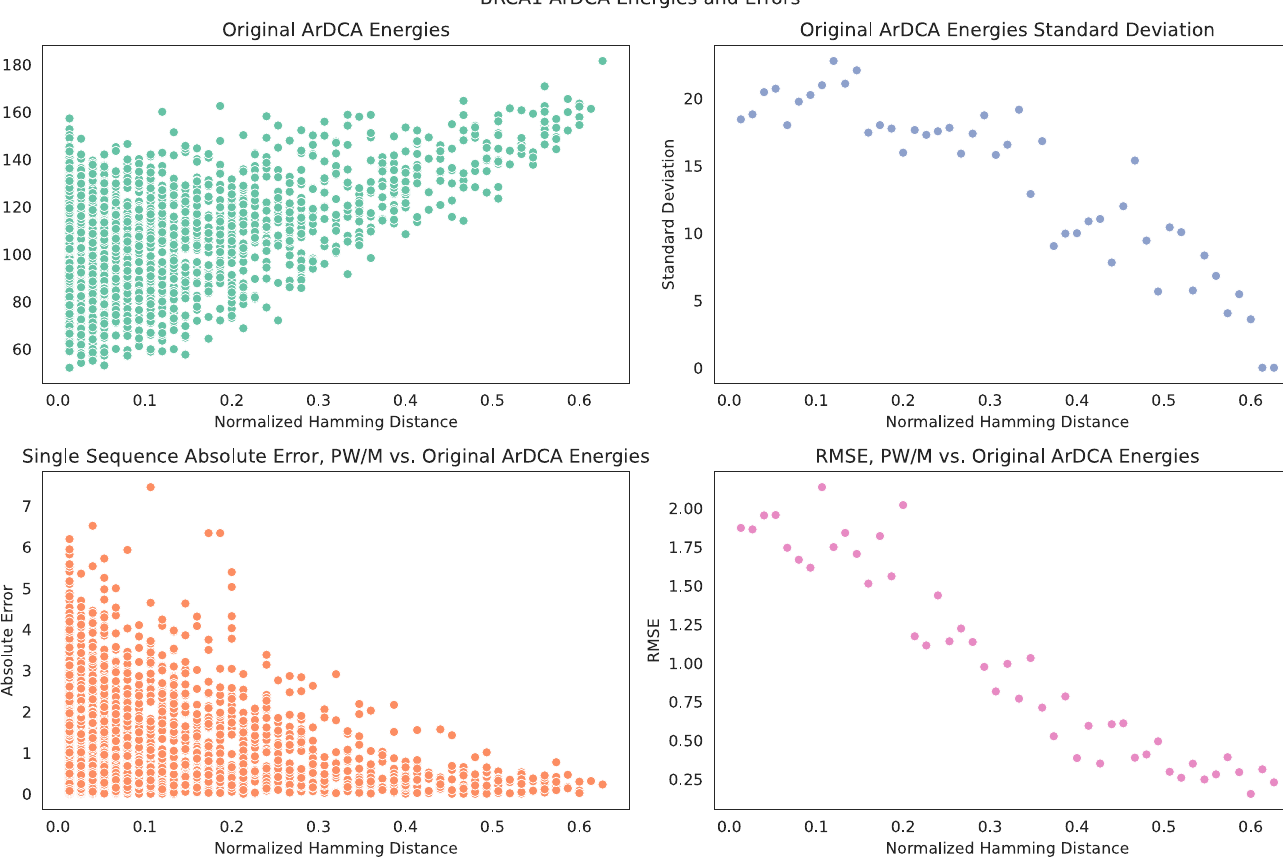
Fig 6. Energies and their standard deviations on BRCA1 test sequences. All plots share the abscissa, which shows the normalized Hamming distance of the test sequences to the closest sequence in the training set. Upper left: Energies of individual test sequences in the original ArDCA model. Lower left: Absolute errors on individual test sequences of a pairwise model extracted with sequences sampled from the original model distribution M with respect to the original energies. Upper right: Standard deviation of the energies in the original model at a given distance. Lower right: Root-mean-squared error on all test sequences at a given distance for a pairwise model extracted with sequences sampled from the original model distribution M with respect to the original energies.